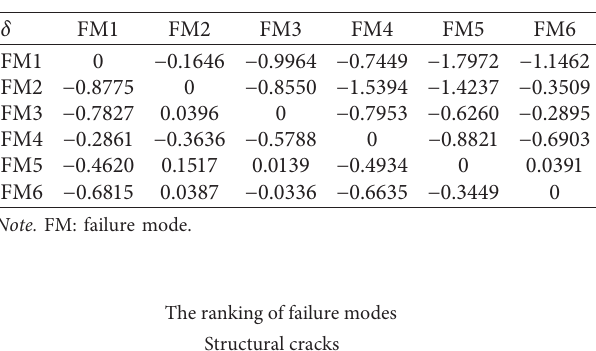
Table 6: Overall dominance matrix.